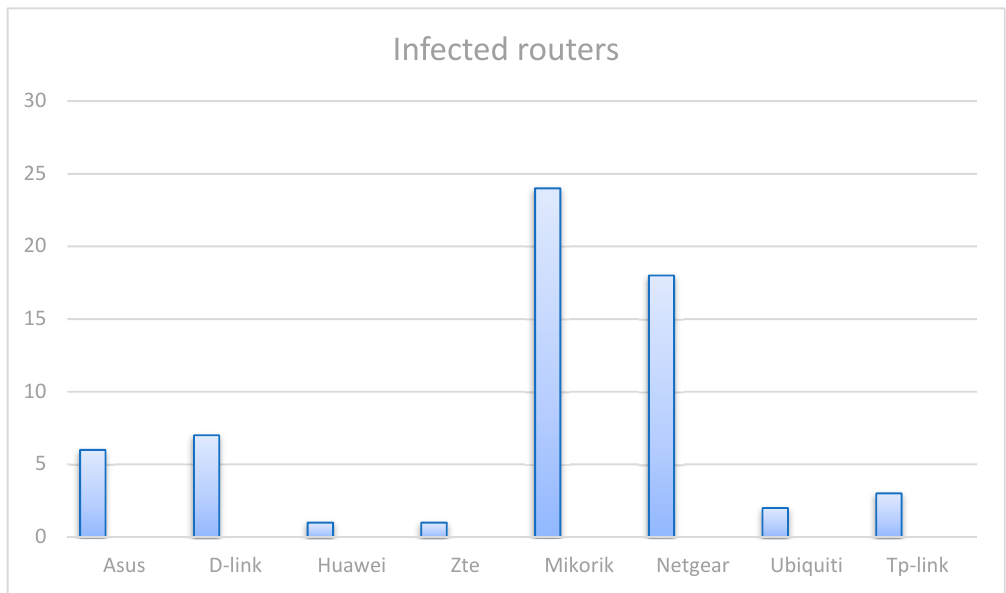
Figure 4. Infected router .